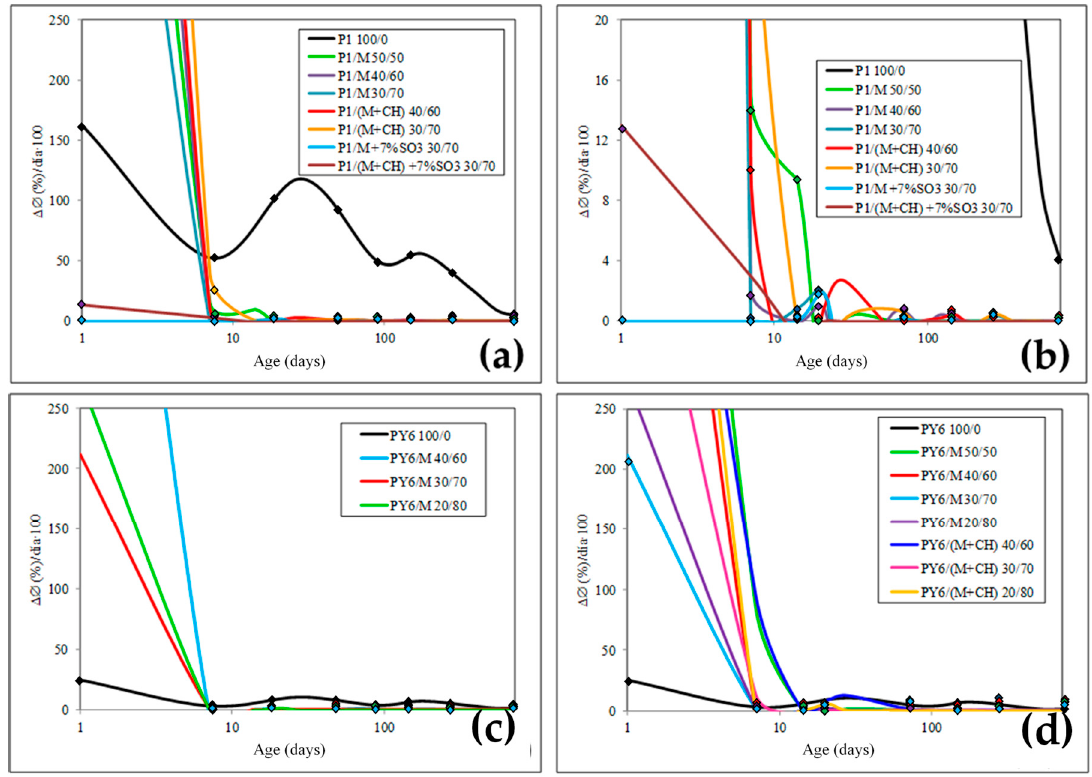
Figure 4. L–A specimens: diameter growth rate, V CØ (%), versus age. ( a , b ) P1 and their M blended cements, ( c , d ) PY6 and their M blended cements.